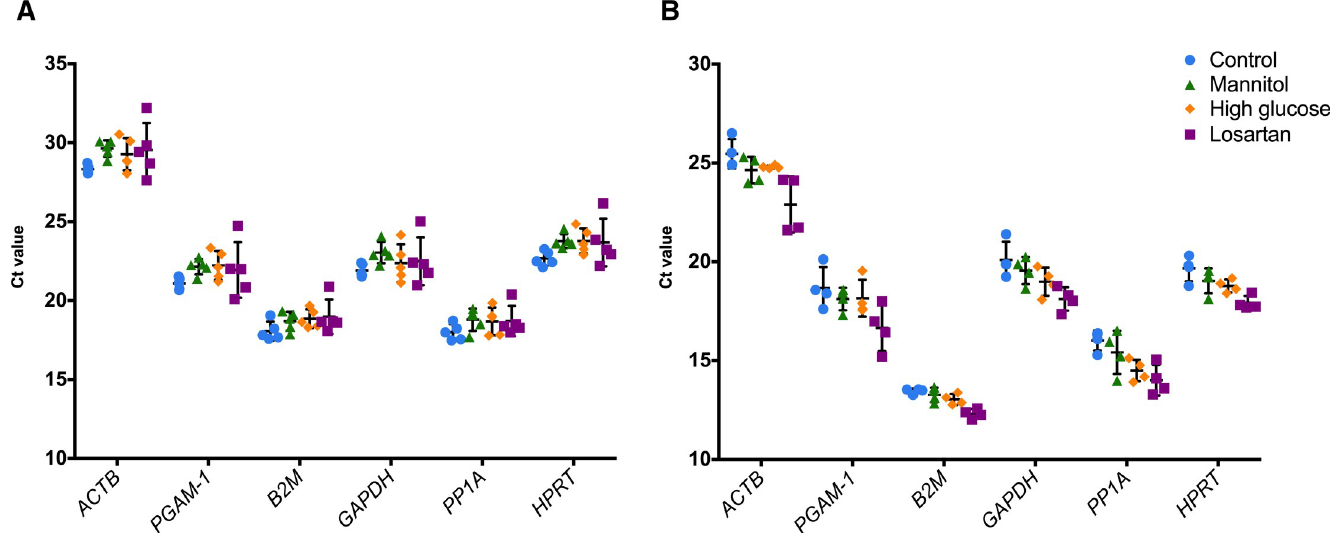
Fig 3. Expression profile of the six candidate reference genes in mesangial cells (A) and podocytes (B). A lower threshold value (Ct) represents a higher gene expression level. The data are presented as the mean +/- standard deviation. Each dot represents the average from triplicate Δ Ct from each sample. All genes were tested for differences among the groups (Kruskal-Wallis test), and all comparisons showed a nonsignificant result (p > 0.05).